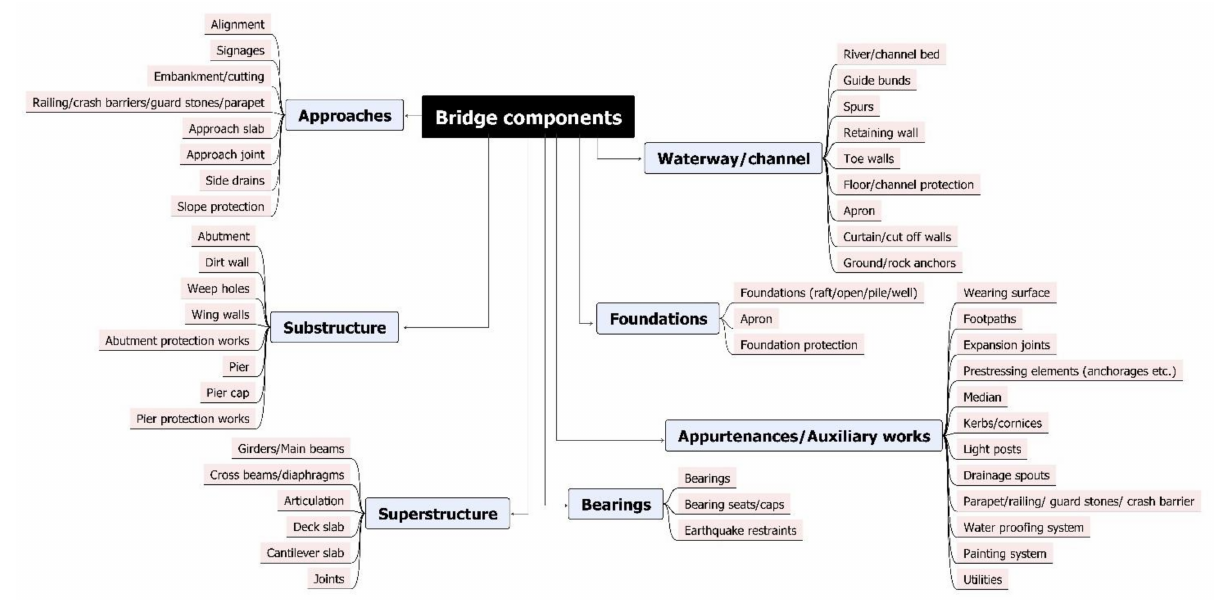
Figure 1. Decision tree in Sanjay and Kumar